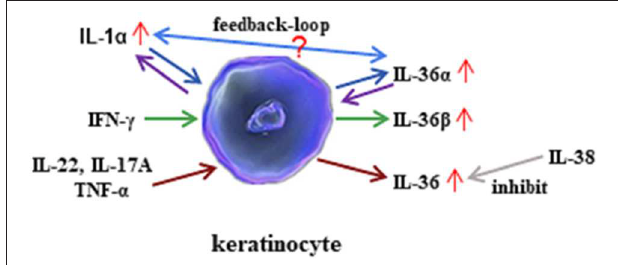
FIGURE 3 | Regulation of interleukin (IL)-36 in keratinocytes. IL-36 α regulates the generation of IL-1 α in keratinocytes. In turn, IL-1 α affects the synthesis of IL-36 α in keratinocytes. However, the mechanism of feedback loop needs to be elucidated in the future. Interferon (IFN)- γ induces IL-36 β production in keratinocytes. In addition, inflammatory cytokines such as IL-22, IL-17A, and tumor necrosis factor (TNF)- α induce all three agonists’ expression, whereas the effect may be inhibited by IL-38